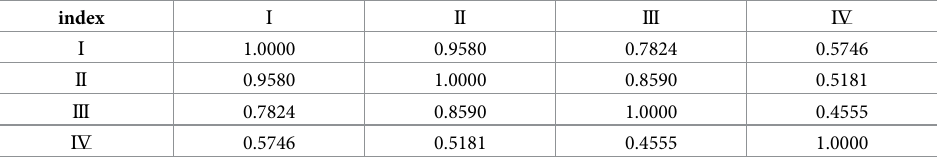
Table 3. Relational coefficient matrix.